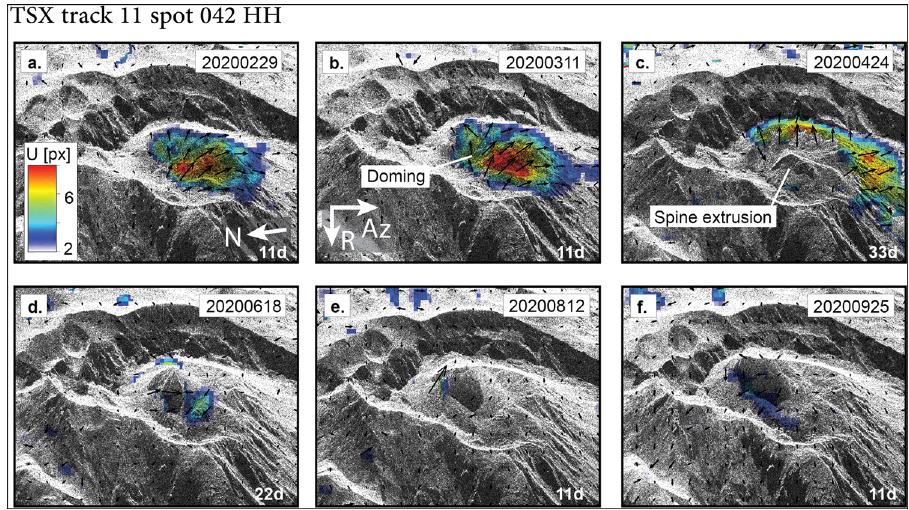
Fig. 3 Radar amplitude observations. Color represents pixel offsets calculated at cross correlation windows of 32 × 32 pixels minimum, for data pairs of single, double or triple repeat pass (with 11 day, 22 d, and 33 d time window). Displacement U is shown in pixels [px]. a Up to 7 px displacement affects the summit region. b Displacement increases to 8 px in 11 days ( d ). c With fi rst spine extrusion, the large displacements disappear. d Minor displacement of the dome, while the spine extrudes. e Spine extrusion continues, migration northwards. f The spine widens and/or bends further to the NE. Note the occurrence of doming fi rst, then spine extrusion (without doming). Images shown in radar coordinates (azimuth in x -axis, range in y -axis), 1 px is 1 m² approximately, descending TSX track 11 spot 042 HH. North to the left, east is up, west is